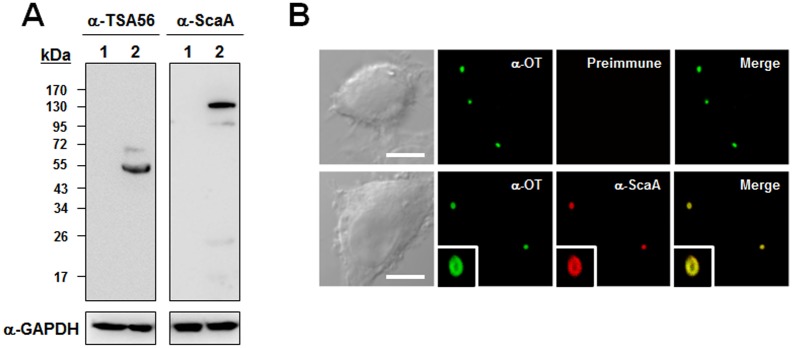
Expression of ScaA by O. tsutsugamushi.(A) Immunoblot analysis of whole proteins from L929 cells infected with O. tsutsugamushi proteins by using anti-ScaA serum (right panel). Anti-ScaA serum detected a protein with a molecular mass of approximately 150 kDa. Immunoblotting using anti-TAS56 was performed as a control (left panel). (B) Immunofluorescence confocal microscopy using preimmune serum or anti-ScaA serum (α-ScaA) showed ScaA in the O. tsutsugamushi-infected L929 cells. The left panels show bacteria stained with the pooled sera of scrub typhus patients (α-OT). Magnified images are shown in the lower panels (inset boxes). Scale bars, 5 μm.